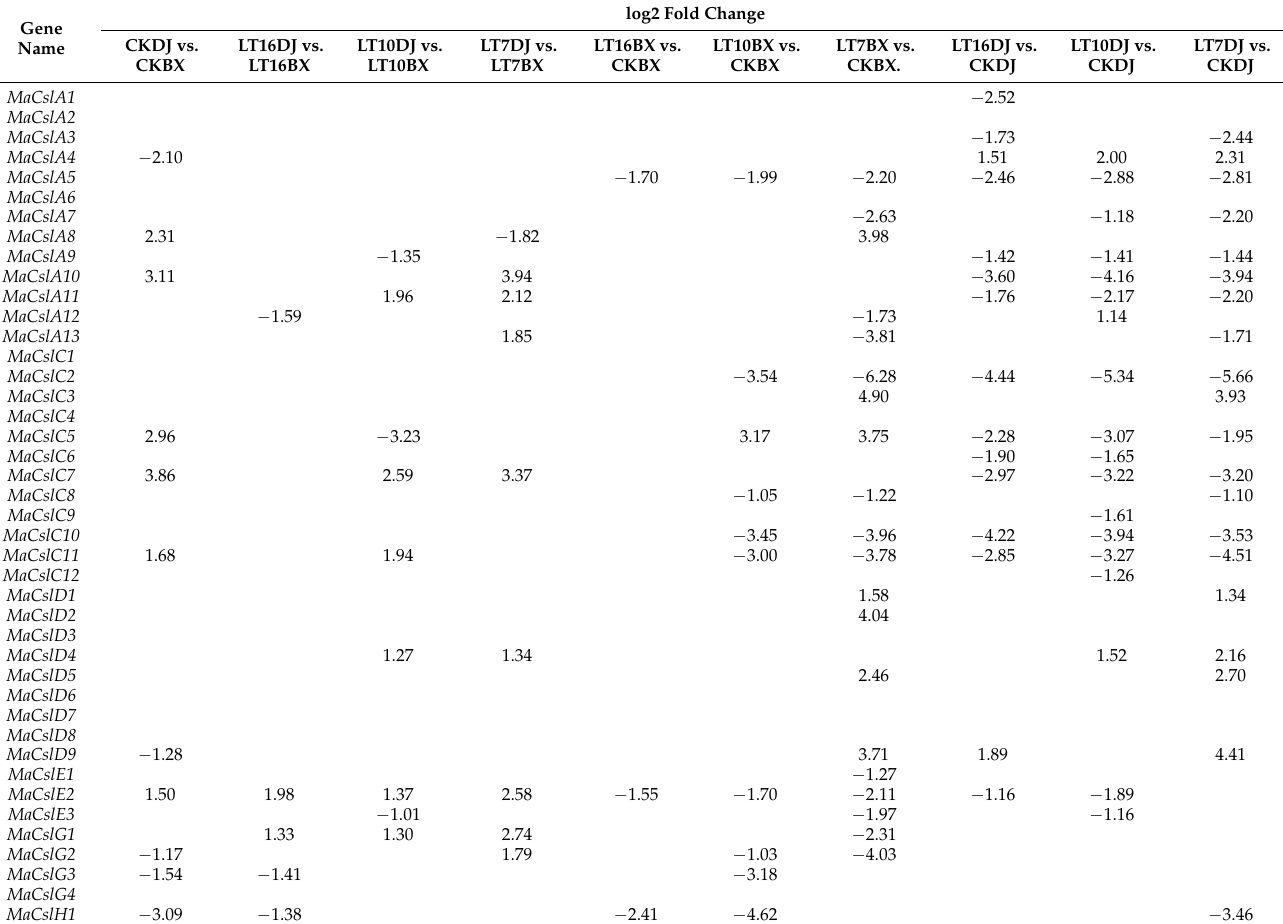
Table 2. Analysis of differentially expressed MaCsl genes in banana ( Musa spp.) leaves under low